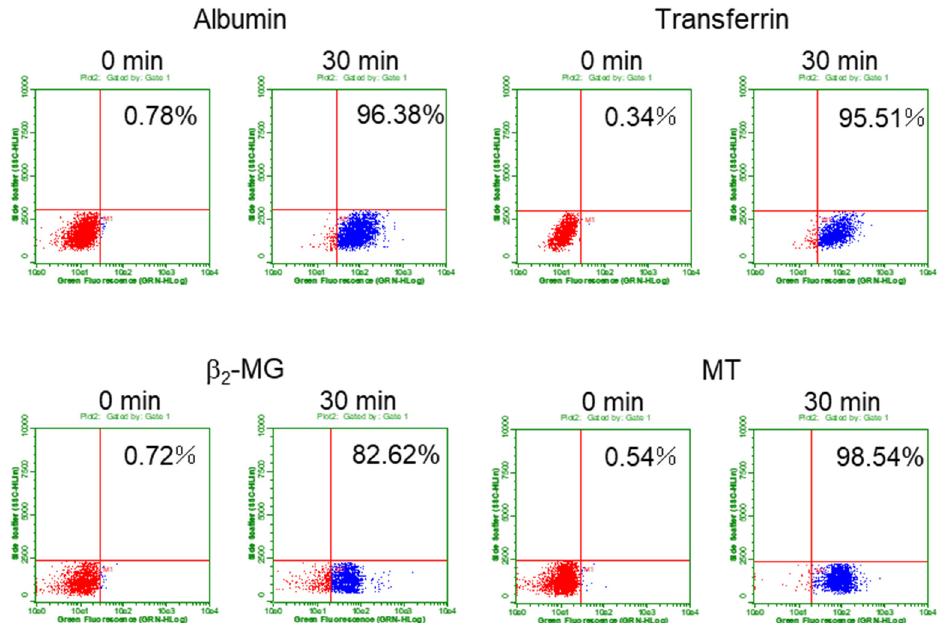
Figure 2. Evaluation of endocytosis efficiency of the fluorescent-labeled proteins by using flow cytometry. The cells were cultured with each of the fluorescent-labeled protein for 0 or 30 min and applied to flow cytometry. Typical quadrant data of each protein in S1 cells were shown here. X-axis indicates fluorescent intensity and y-axis indicates side scattering. The untreated cells (0 min) showing the auto-fluorescence were gated to be the lower-left section in the quadrants. The cell populations in the lower-right section were expressed as the percentage of total cells and used as the indicator of endocytosis efficiency (%) in the subsequent experiments.